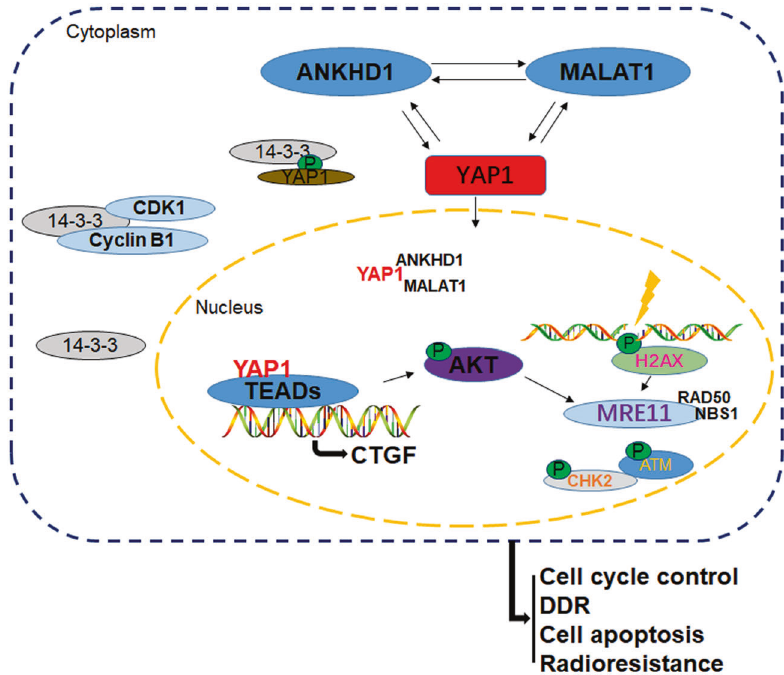
Fig. 8 Overall schematic diagram. There is an ANKHD1/MALAT1/YAP1-feedback loop in CRC cells, which synergistically regulates the nuclear translocation of YAP1 and promotes the transcriptional coactivation of YAP1. Subsequently, YAP1-mediated activation of AKT increases the expression of the MRN complex and then activates the ATM/CHK2-checkpoint pathway, promoting DNA damage repair and ultimately resulting in radioresistance in